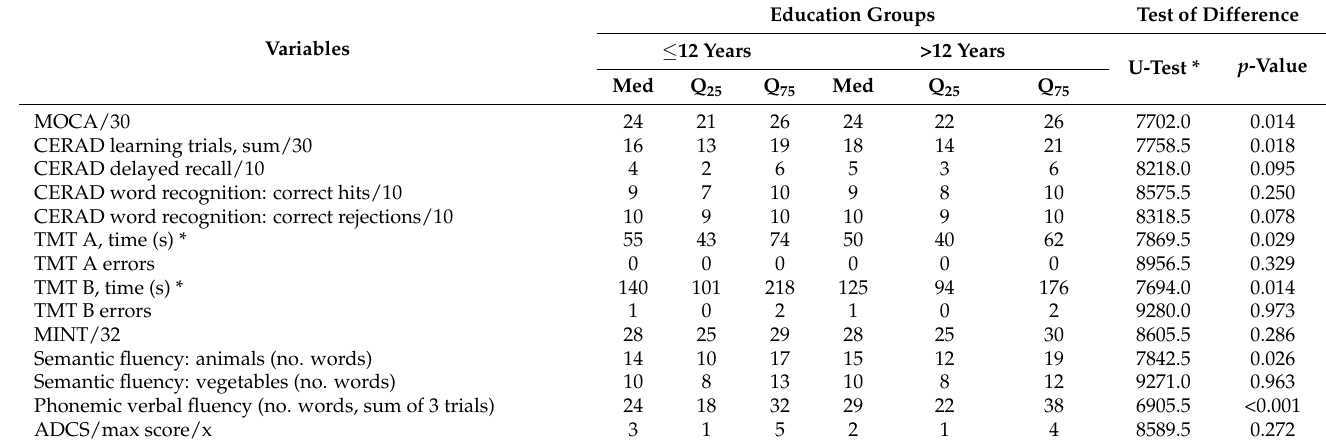
Table 6. Summary statistics for neuropsychological test scores for education groups.